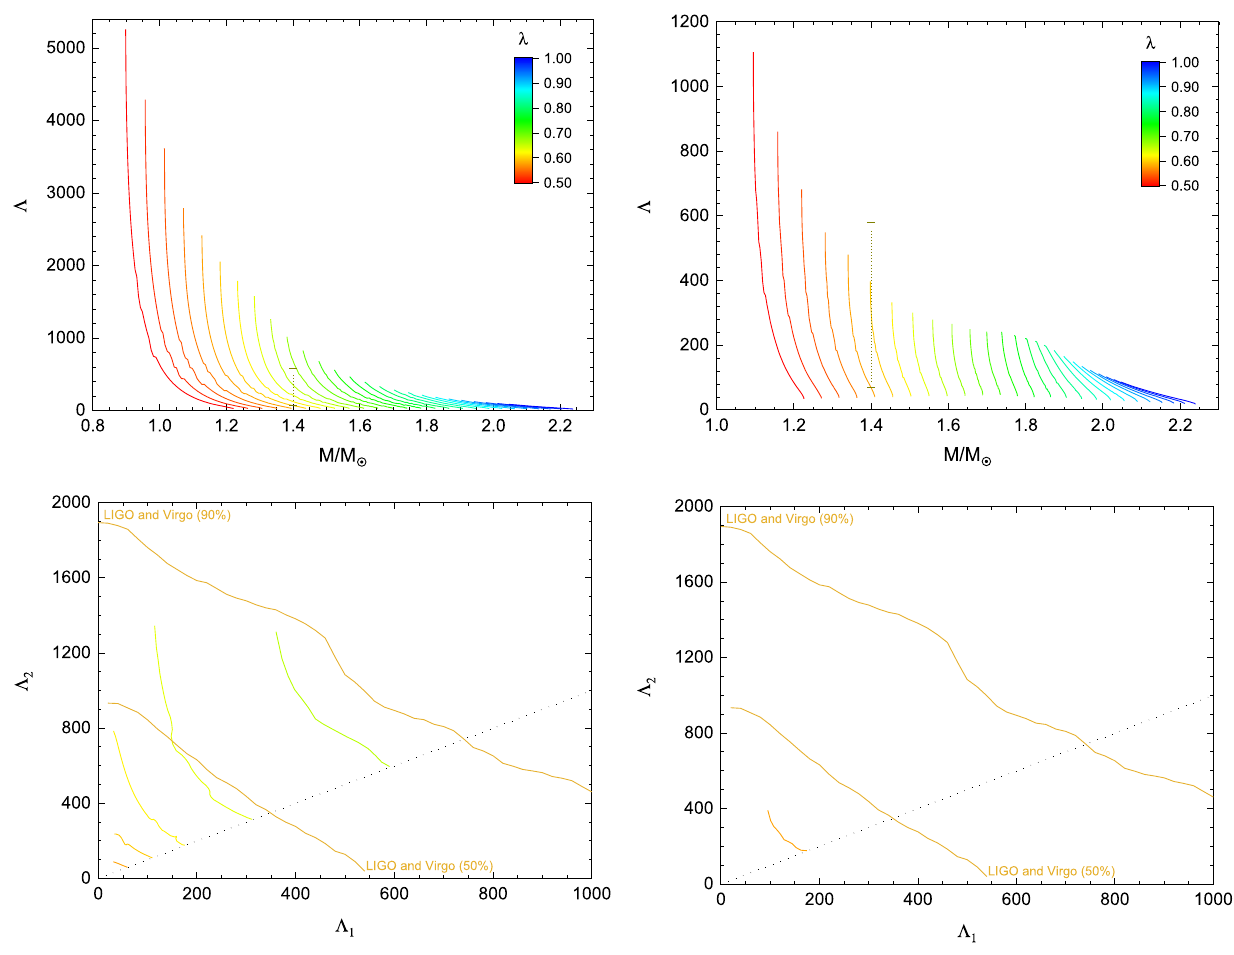
Λ = Λ 1 2 limit. The solid top and bottom yellow lines denote respec- tively90%and50%levelestablishedbyLIGO-Virgoscientificnetwork in the low-spin prior scenario. On the left and right panels are used ρ dis = 7 . 0 × 10 17 [ kg / m 3 ] and ρ dis = 9 . 0 × 10 17 [ kg / m 3 ] , respec- inn inn tively. Only stable equilibrium configurations with rapid conversions at the interface considering Γ inn = Γ out = 2 . 4 are